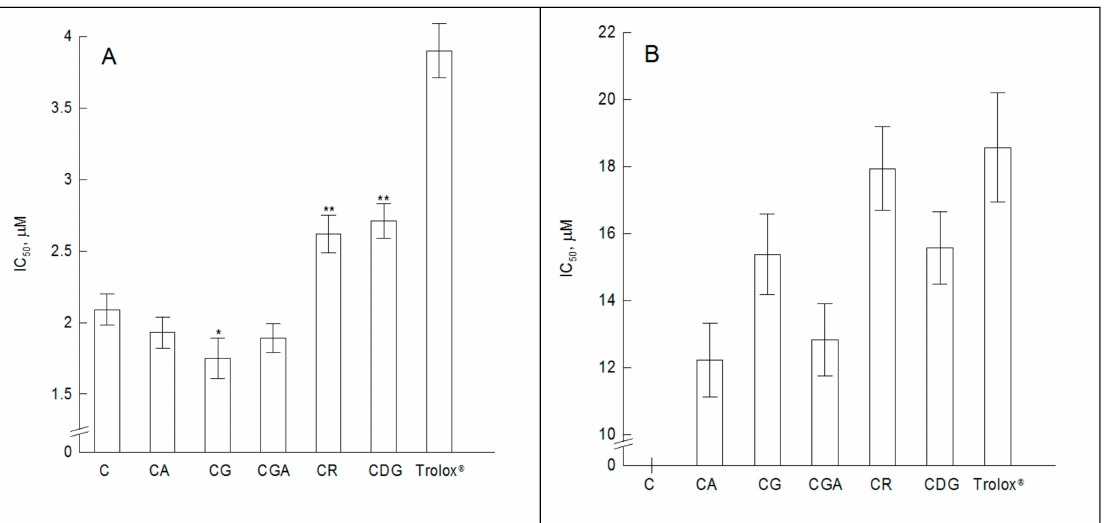
Figure 5. The concentrations (IC 50 ) of cyanidin, its glycosides and Trolox ® responsible for 50% inhibition of lipid peroxidation in POPC LUVs. The oxidation of lipids was induced: ( A ) for 30 min by AAPH and ( B ) for 3 h by H 2 O 2 . In BODIPY method the determination of IC 50 concentration of C was impossible due to its strong aggregation of POPC liposomes that occurs at effective concentration range. The statistically significant differences between antioxidant activity of C and its glycosides are denoted: * α = 0.1 and ** α = 0.05.